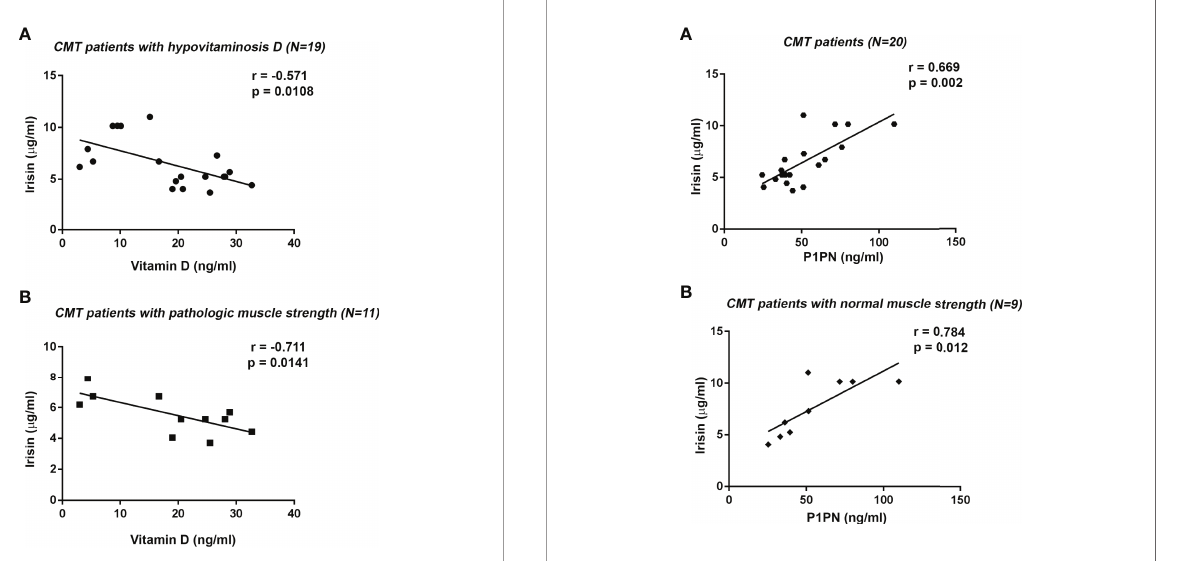
TABLE 4 | Multivariate linear regression model to investigate the determinants of P1PN; b and p values as indicated. Dependent variable: P1PN (ng/ml)